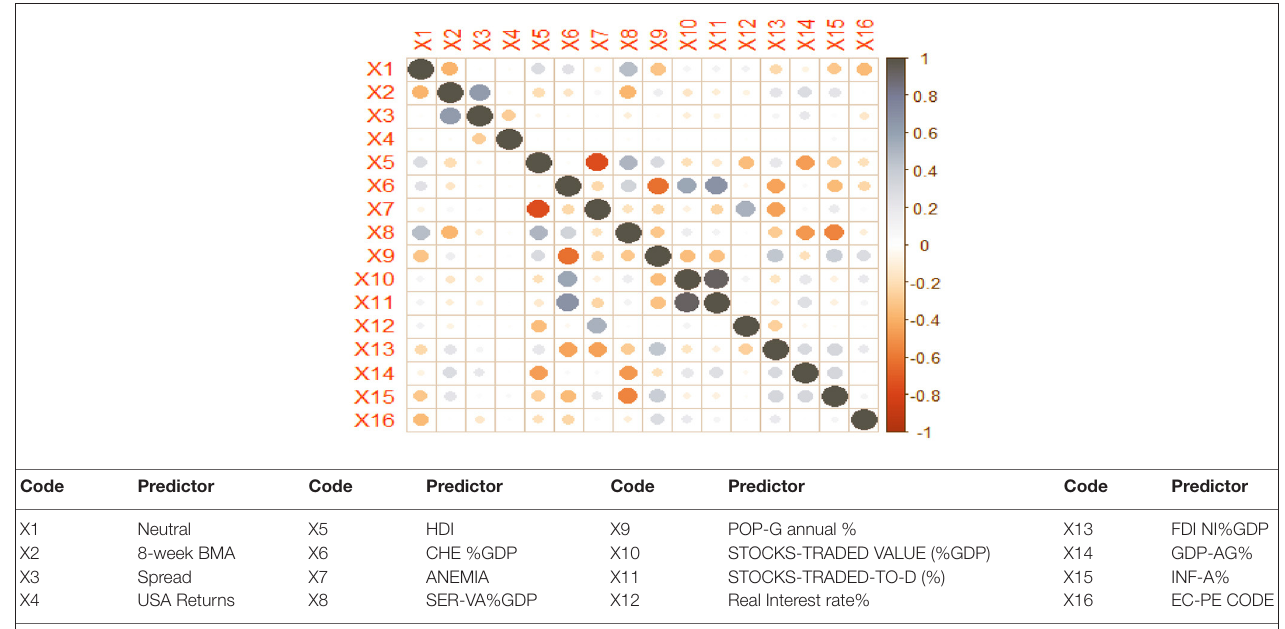
FIGURE 3 | Correlation between remaining 16